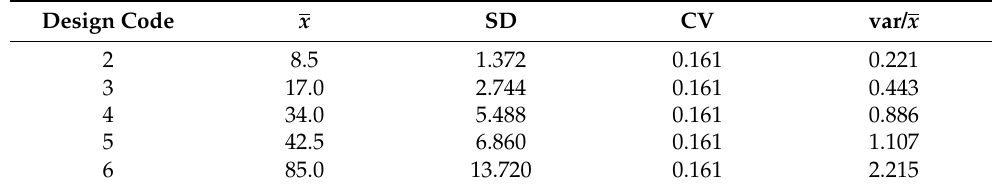
Table 5. Plant population statistics calculated by multiplying the results for the mosaic size of 1.5 m 2 . Design Code x